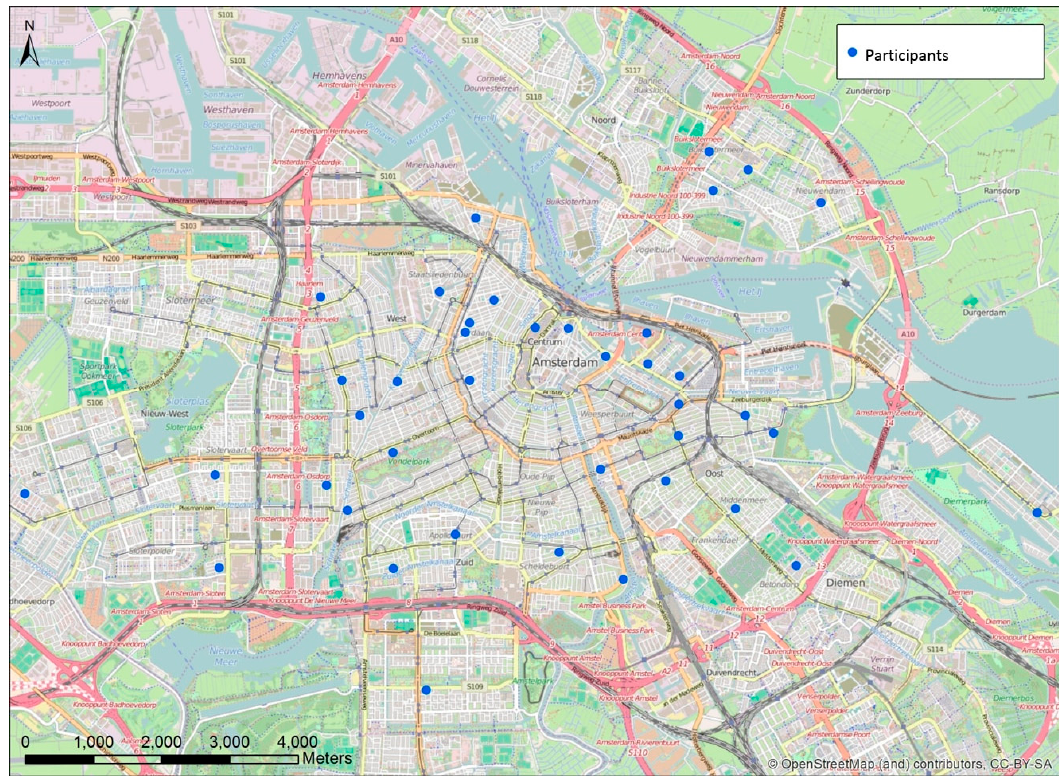
Figure 2. Participating citizen scientists at postal code level, Amsterdam.